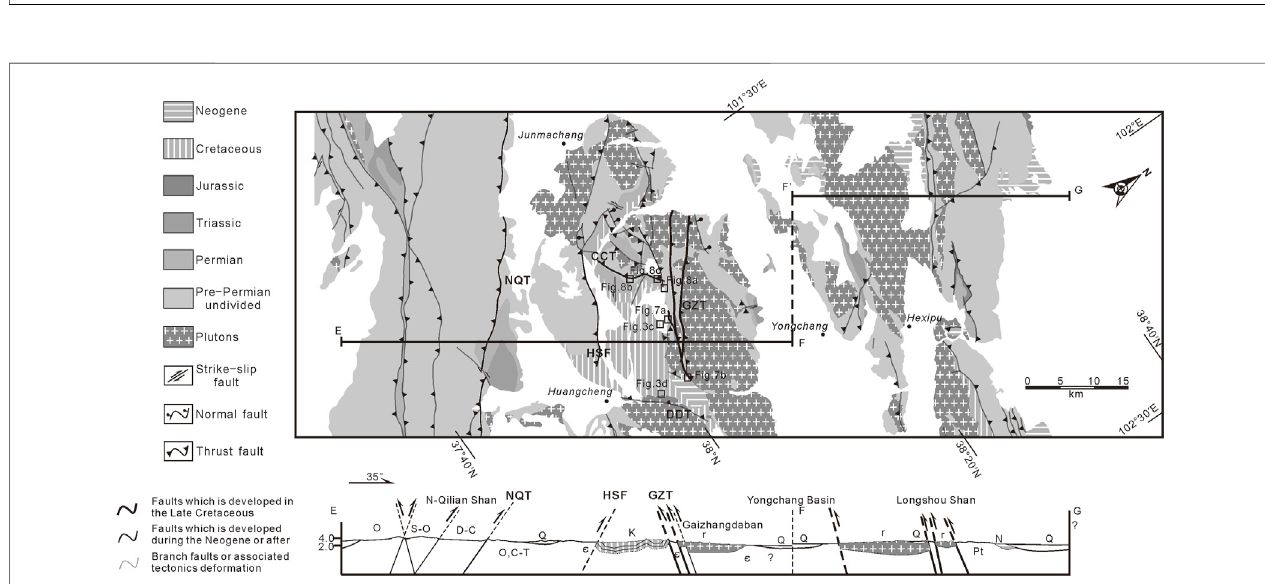
FIGURE 5 | Field map of the Huangcheng area. (Map based on data from the Bureau of Mineral Resources of Gansu Province (BMRGP, Regional Geological Survey)(1982),BMRIMP(1991),BureauofMineralResourcesofQinghaiProvince(BMRQP,RegionalGeologicalSurvey)(1991)and fi eldworkconductedforthisstudy).